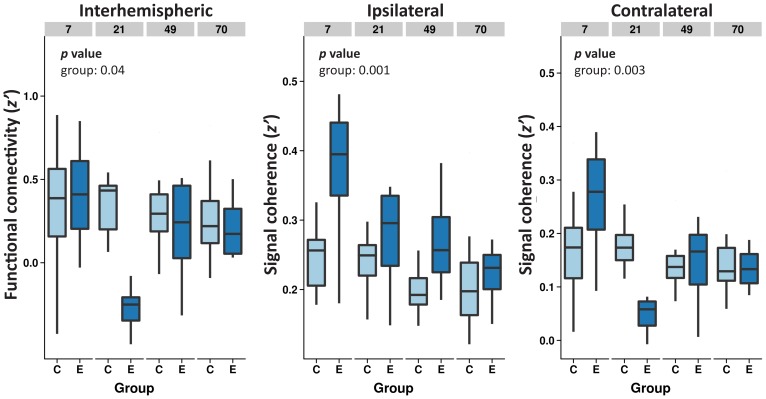
Functional connectivity between and within hemispheres.Interhemispheric functional connectivity (as normalized correlation: z') between the ipsilateral and contralateral sensorimotor cortical regions (left graph), and intrahemispheric functional connectivity (as volume of voxels connected with the sensorimotor ROI within the same hemisphere) for the ipsilateral (middle graph) and contralateral hemisphere (right graph) in the controls (C) and epilepsy (E) groups. Interhemispheric functional connectivity was stable over time in controls, but lowered at day 21 in the epilepsy group. The intrahemispheric functional connectivity was increased in the epilepsy group up to seven weeks, but declined to control levels at the latest time point. Statistical significance obtained from the linear mixed model analysis is indicated for factor with p<0.05.